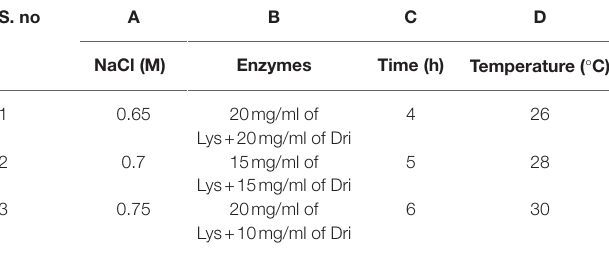
TABLE 3 | Orthogonal experimental design.